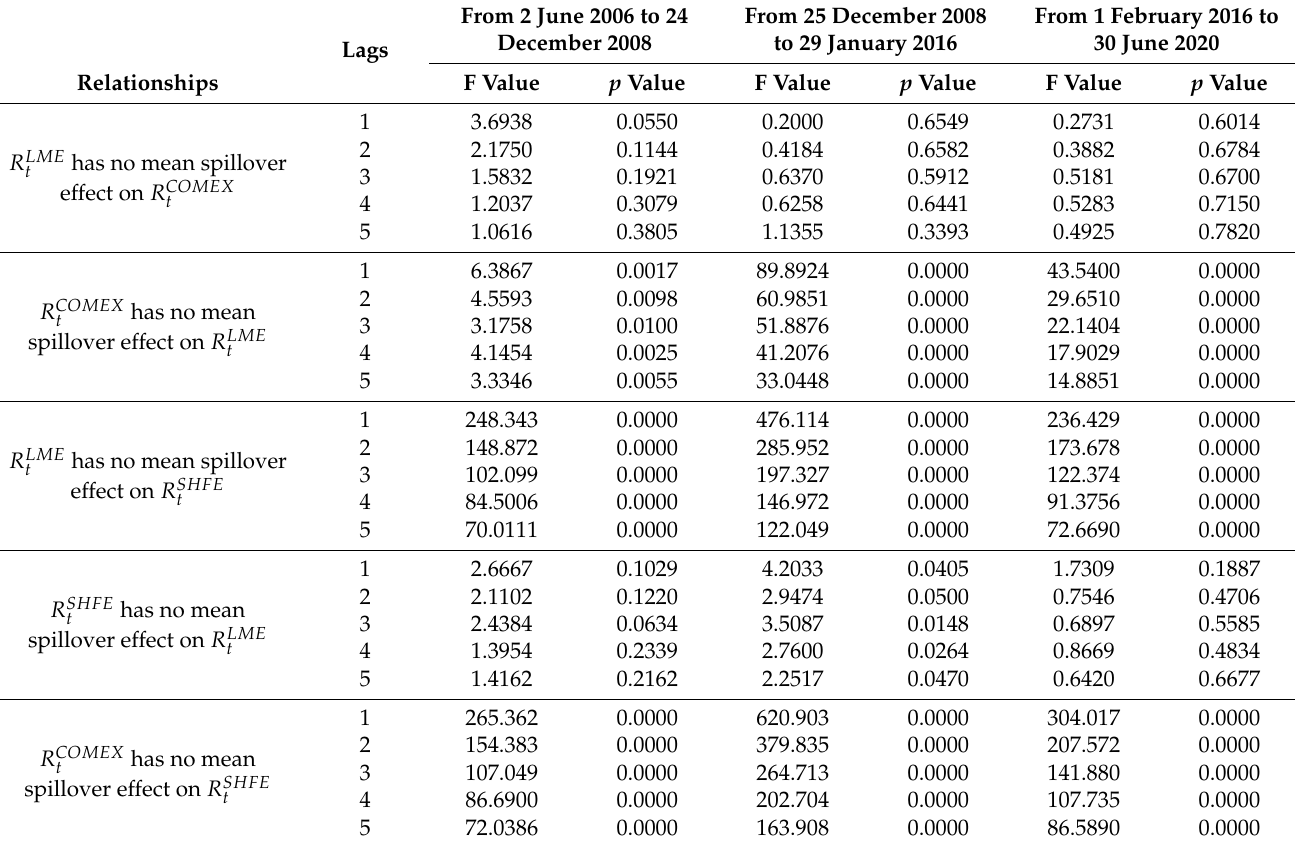
Table 8. Granger causality tests of three markets at different